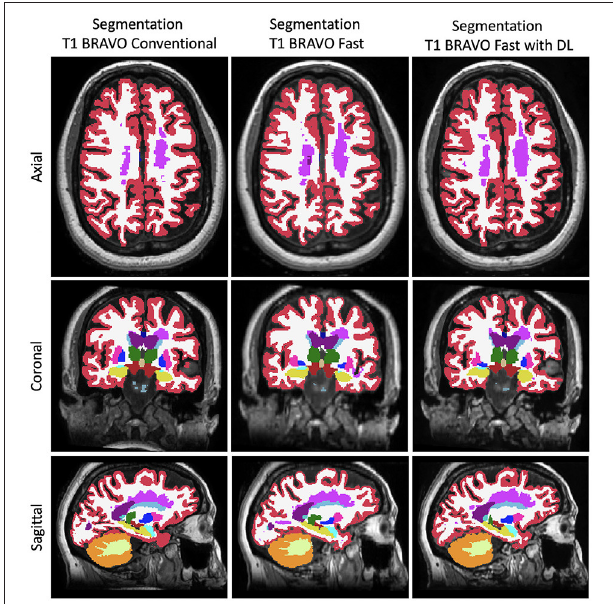
FIGURE 3 | Representative FreeSurfer segmentation images. Slices in a similar position for the FreeSurfer segmentation derived from the three different methods to generate the images.